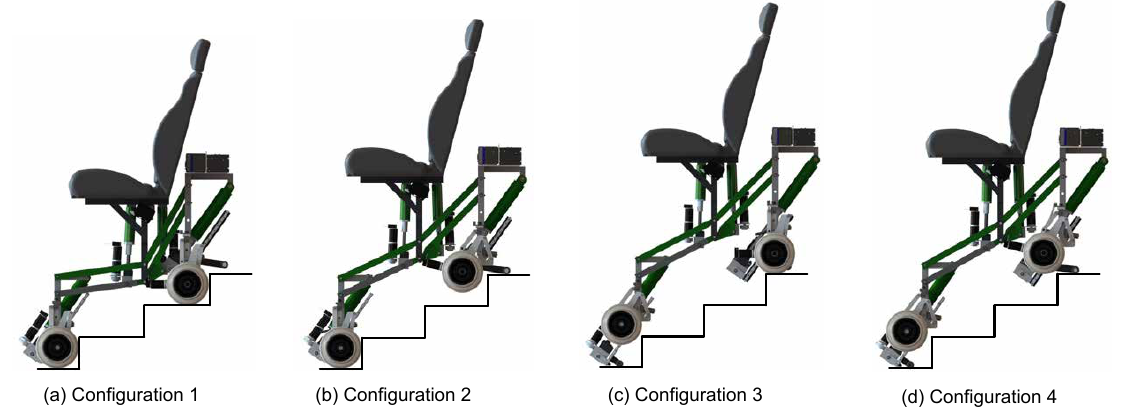
Figure 4. Possible configurations of the